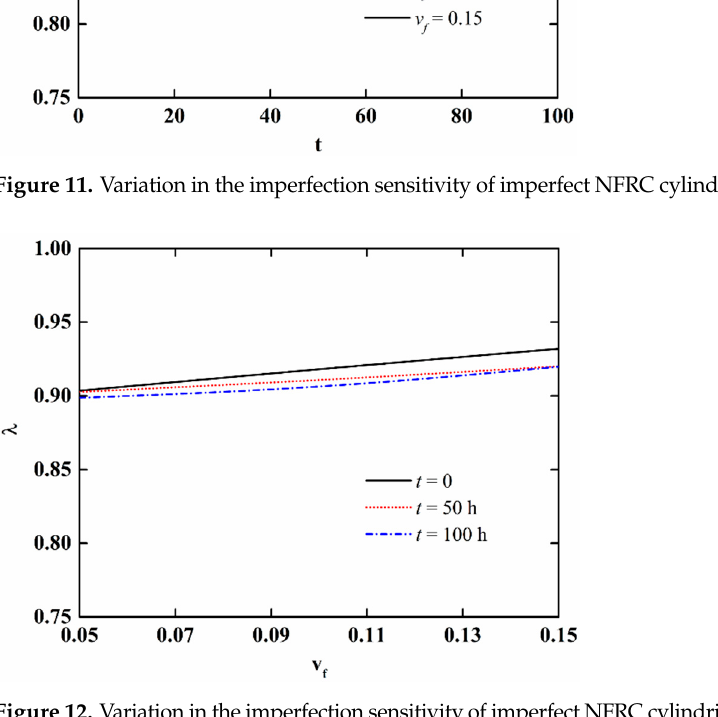
Figure 12. Variation in the imperfection sensitivity of imperfect NFRC cylindrical shells with fiber content.